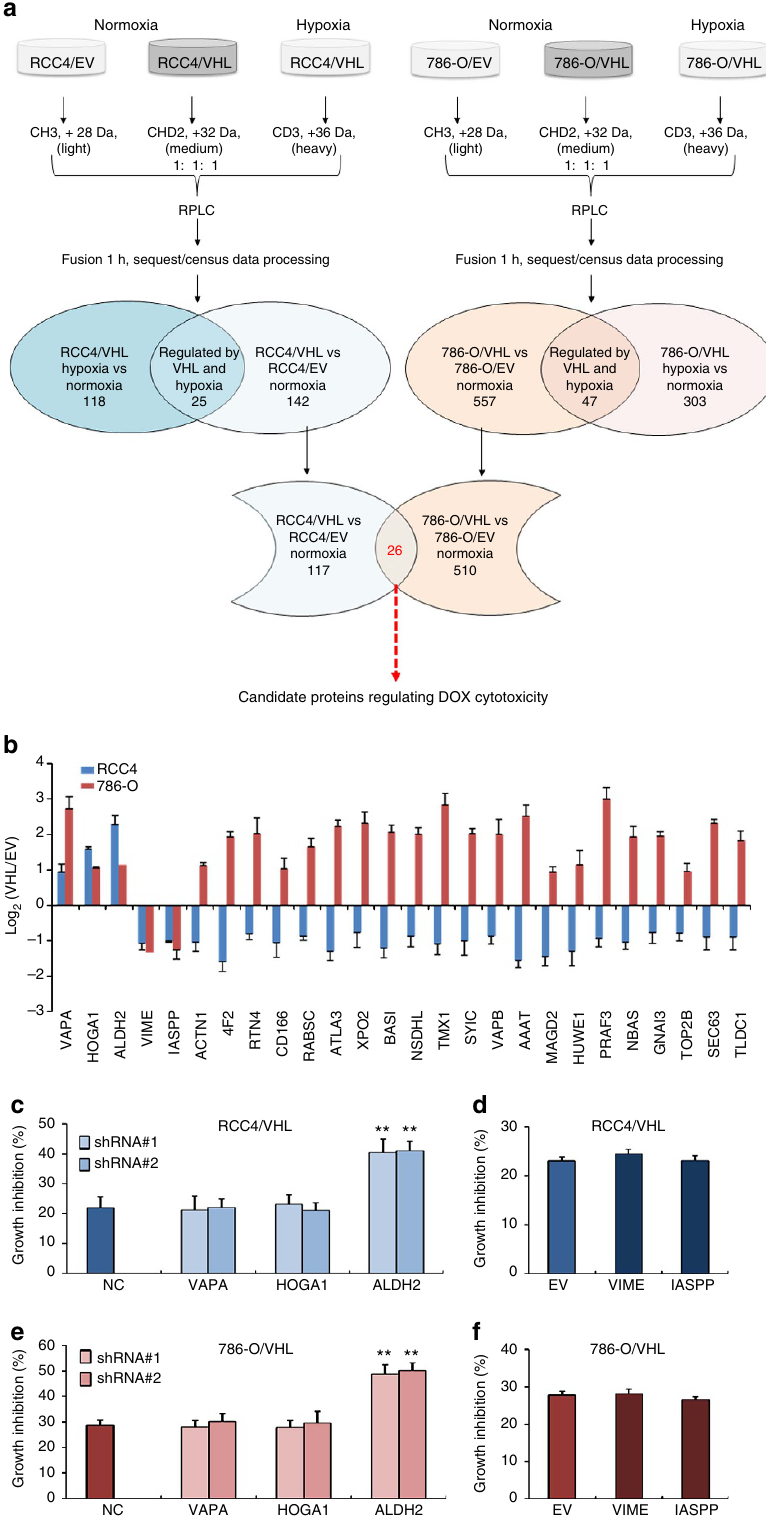
Figure 4 | Subtractive proteomic analysis reveals candidate proteins regulating cytotoxicity of anthracyclines. ( a ) The schematic of proteomic work-flow. ( b ) The VHL alone-regulated proteins presented in both RCC4 and 786-O cells. The indicated genes were knocked down ( c , e ) or ectopically expressed ( d , f ) in RCC4/VHL ( c , d ) or 786/VHL ( e , f ) cells following by treatment with 1 m M doxorubicin for 48h and the growth inhibition rates were detected. The indicated cells were compared to their counterpart (NC, non-specific shRNA control; EV, empty vector control) separately. Data represent means and s.d. of three independent experiments. (** P o 0.01 for t